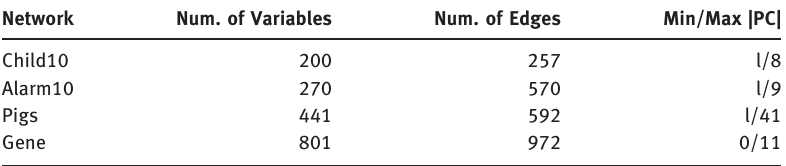
Table 1: Descriptions of expert-designed discrete Bayesian networks. The fourth column gives the minimum and maximum cardinality of the parent and child set for each network. Network Num. of Variables Num. of